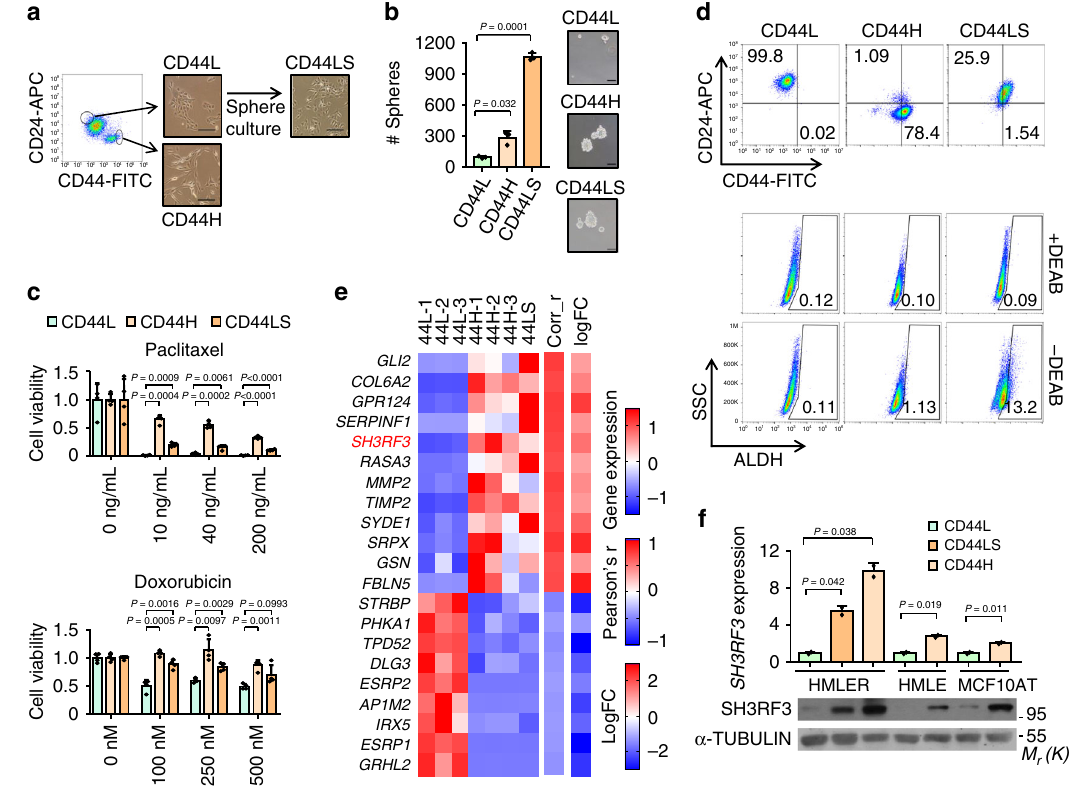
Fig. 1 SH3RF3 expression is associated with BCSC properties. a Flow chart and representative images of HMLER subline derivation. Scale bar, 100 μ m. b Quantitation ( n = 3 culturing experiments) and representative images of tumorspheres in HMLER sublines. Scale bar, 100 μ m. c MTT assays of HMLER sublines after paclitaxel (0 – 200 ng/mL) and doxorubicin (0 – 500 nM) treatment in various concentrations ( n = 4 treatment experiments). d Flow cytometry analyses of CD44 + CD24 − and ALDH + CSCs in HMLER sublines. Numbers in the cytometry charts indicate the percentages of corresponding subpopulations. e Genes associated with CSC properties in clinical tumors and HMLER sublines. Heatmap showed their expression in HMLER sublines, Pearson ’ s r correlation to CSC signature in TCGA tumors (Corr_r) and log-fold changes of expression in tumorspheres versus primary tumors (logFC). f SH3RF3 expression in different sublines derived from HMLER, HMLE and MCF10AT ( n = 3 cell culturing). Data represent mean ± SD. Statistical signi fi cance was determined by two-tailed unpaired t -test ( b , c , and f ). The experiments in ( b ) and ( f ) were repeated three times independently with similar results, and the data of one representative experiment are shown. Source data are provided as a Source data fi